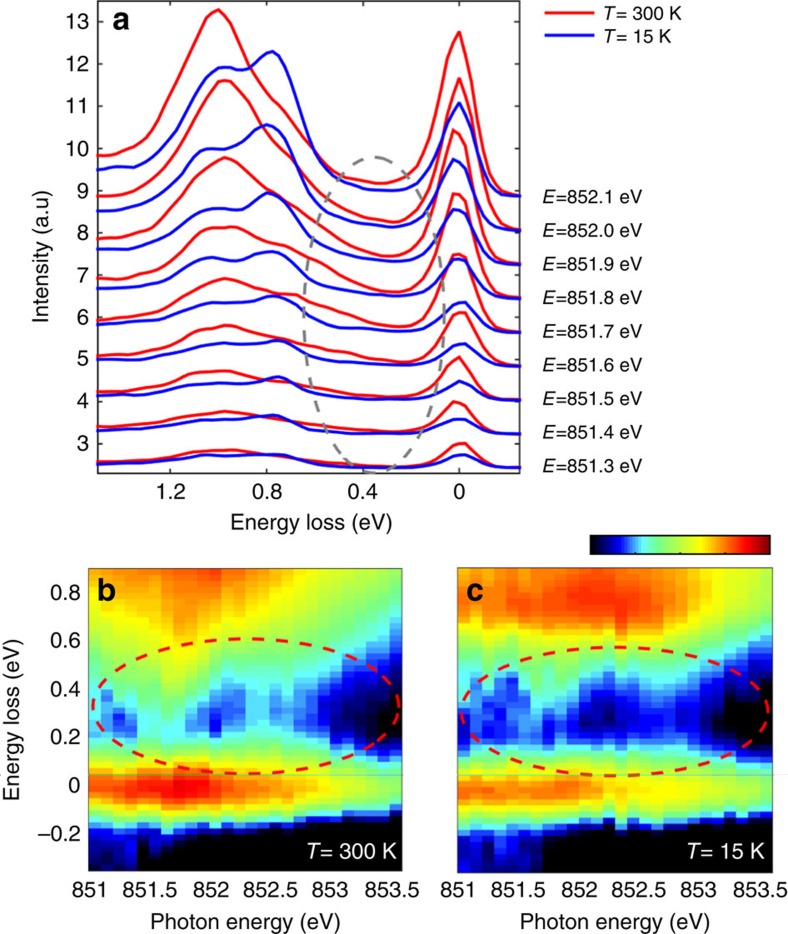
Low-energy electron–hole pair continuum in the RIXS spectra.(a) RIXS line spectra measured for incident energies going from hνin=A-1 eV up to hνin=A-0.2 eV in steps of 0.1 eV at 15 K (blue) and 300 K (red). Each spectrum has been acquired for 5 min. The grey ellipse highlights the energy loss region where the electron–hole pair continuum is more prominent. (b,c), Magnification of the low energy loss region (<0.9 eV) of the RIXS map with a logarithmic intensity scale at 300 K (15 K); intensity scale bar from −3 to 1 (a.u.). The spectra have been normalized to the dd-area to have comparable background signal in the low energy loss region. The red ellipses underline the electron–hole pair continuum present at 300 K (b) and the intensity gap in the same energy window at 15 K (c).